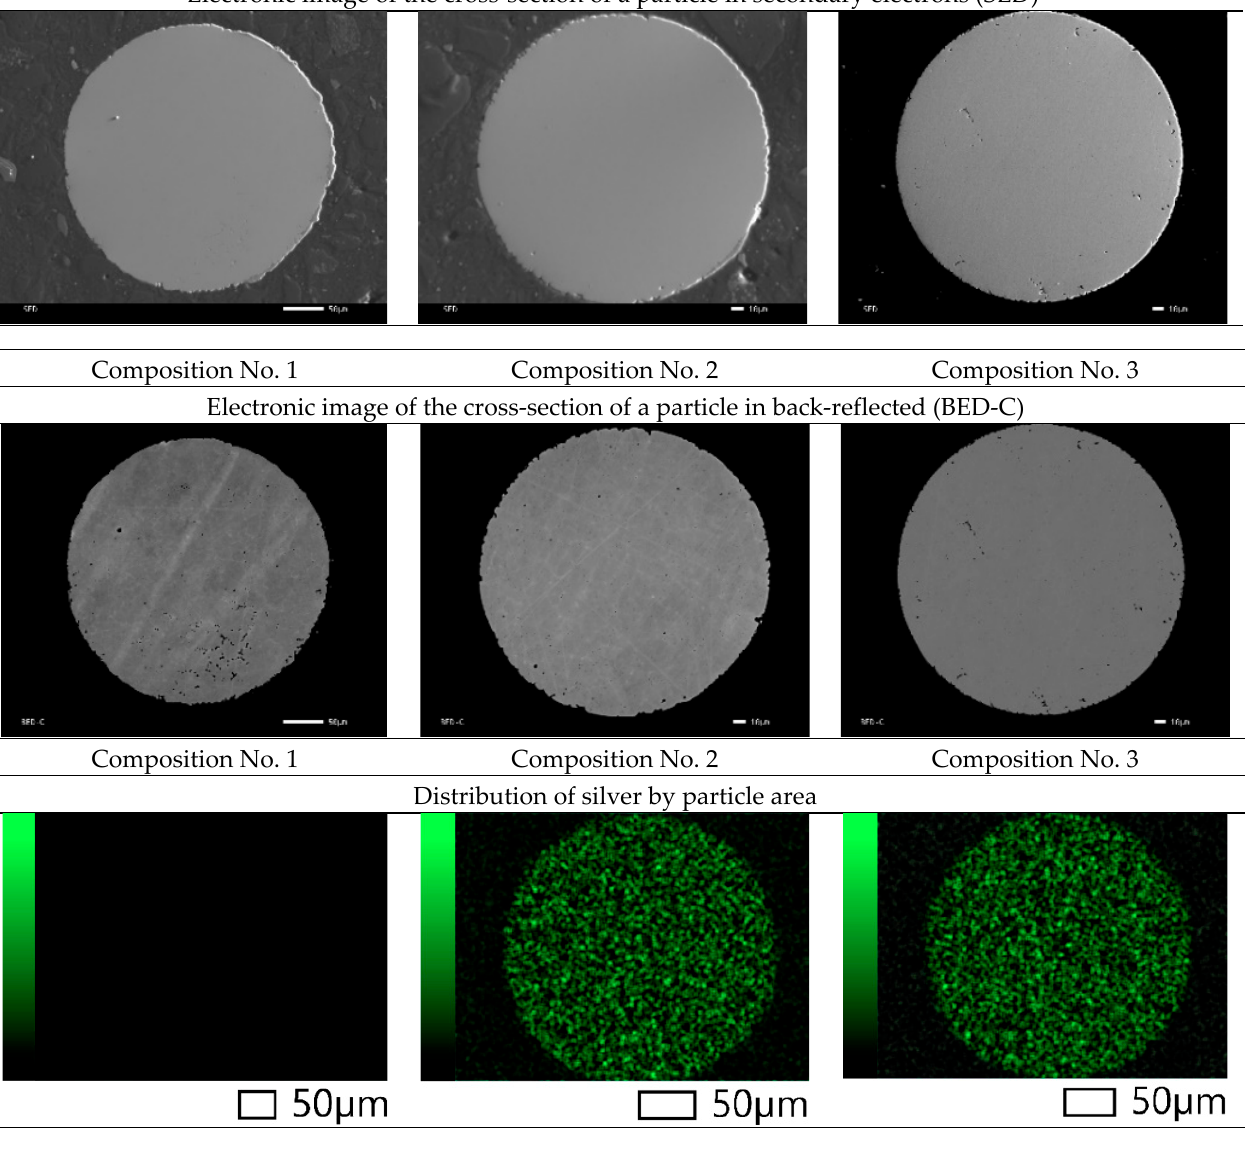
Figure 5. SEM images of the cross-section of powder particles and the distribution of silver over the area (No. 1—316L; No. 2—316L +0.2 wt.% Ag; No. 3—316L +0.5 wt.% Ag).